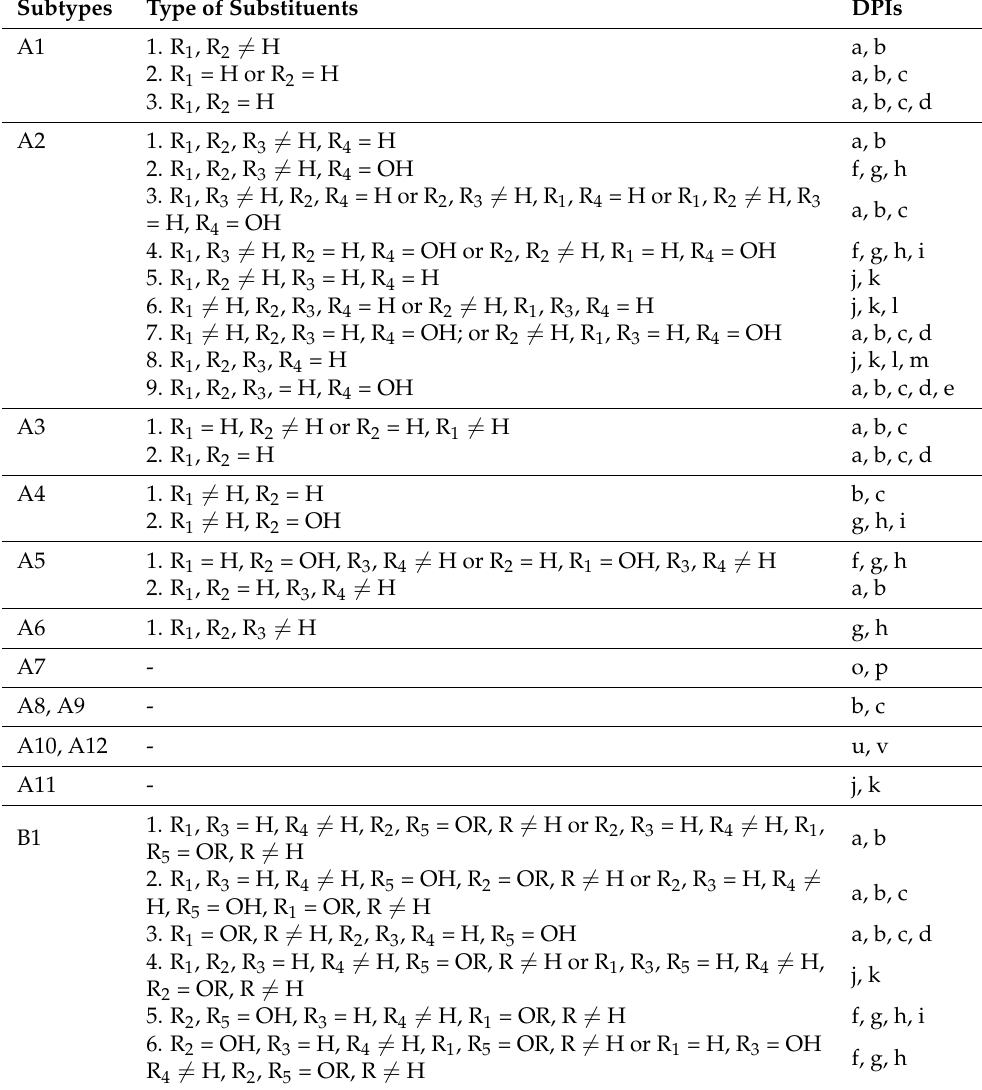
Table 1. The DPIs for twenty-seven subtypes of diterpenoids in Scutellaria barbata . Subtypes Type of Substituents